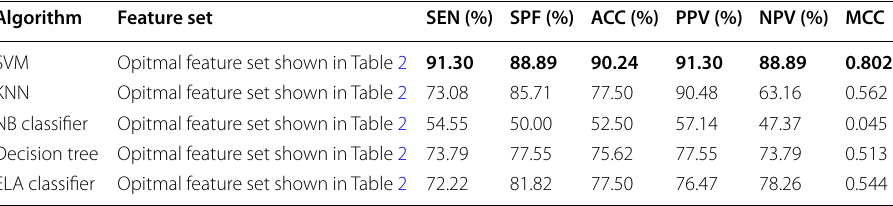
Bold values to highlight the relevant numbers Table 10 Performance indexes for the optimal subset and for each classification algorithm using leave-one-out style under fast walking speed